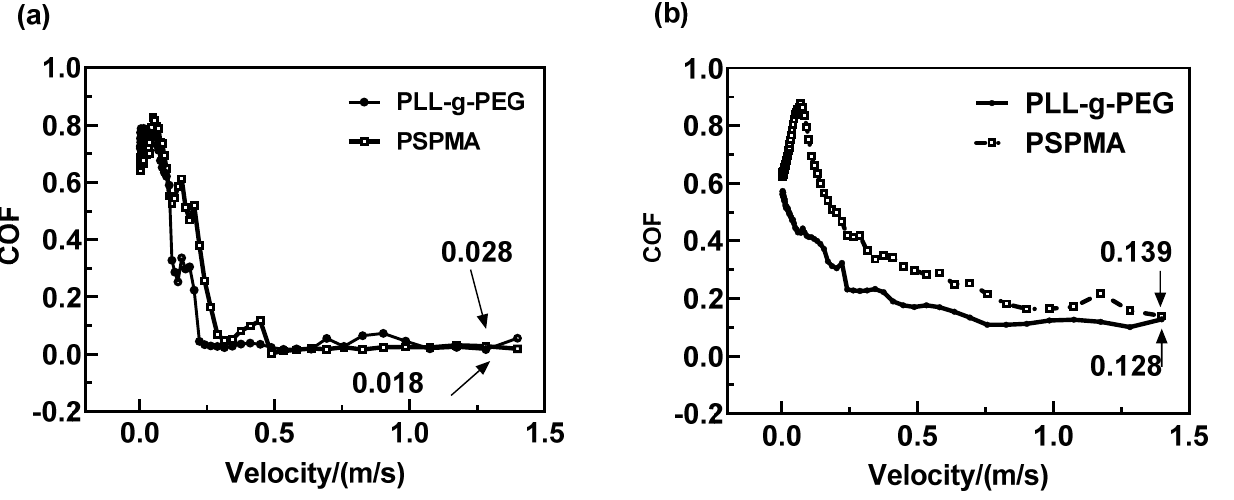
Figure 3. Comparison of Stribeck curves of two polymer brushes at 0.5 N and 3.5 N: ( a ) Load = 0.5 N; ( b ) Load = 3.5 N. With the increase in the entrainment speed, the surface modified by PSPMA had a lower coefficient of friction under 0.5 N load; the PLL − g − PEG modified surface had a lower coefficient of friction under 3.5 N load.